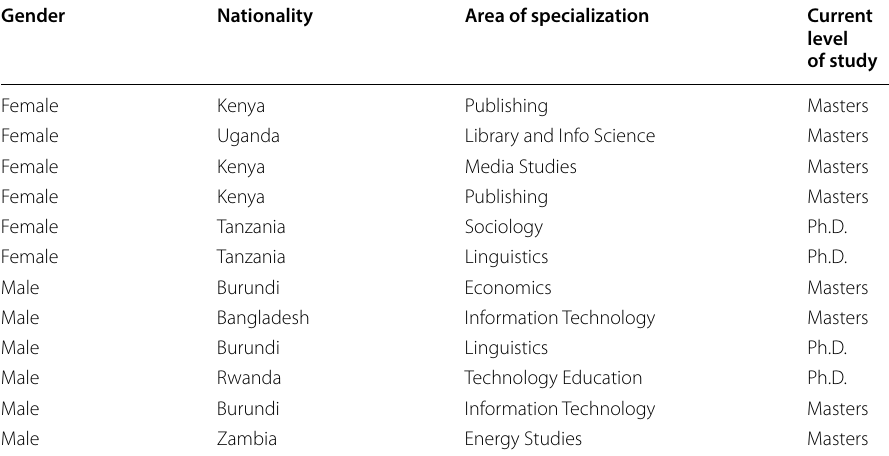
Table 2 Details of Subjective Assessment Panellists